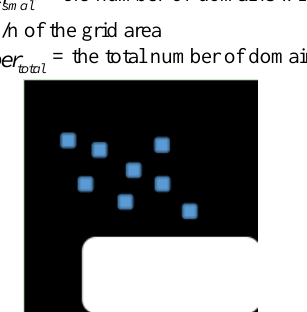
Figure 4. A diagram of fragmentation index calculation Figure 4 shows how to calculate the fragmentation index, domains with an area larger than 1/n of the grid area are represented as white, while domains with an area less than 1/n are represented as blue. It can be seen that numbertotal is 9